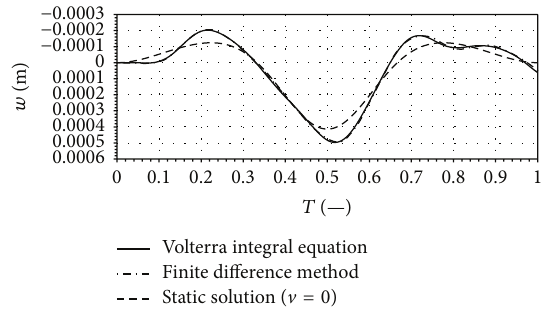
Figure 18: Dynamic deflection of point “b” due to a moving force.